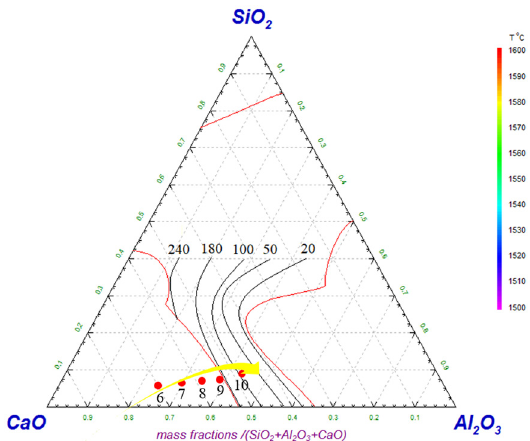
Figure 9. Inclusion-adsorption capacity of refining slag with different Al O contents in ULC automotive 2 3